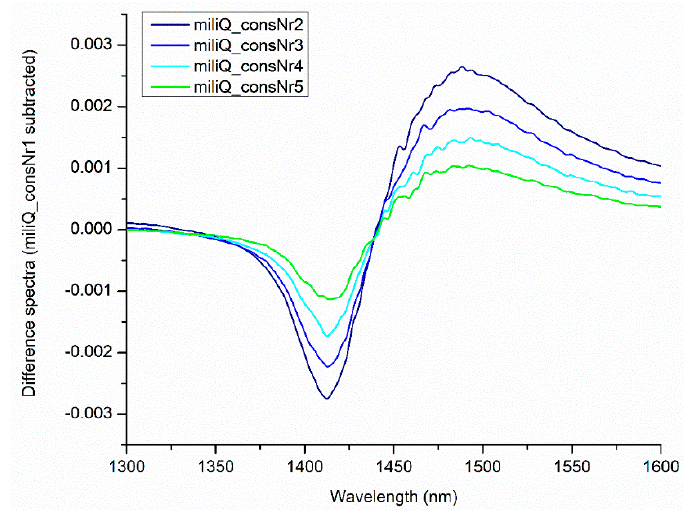
Figure 5. Consecutive illumination of water changes the near infrared spectra. Di ff erence spectra calculated by subtracting the first consecutive spectrum from four subsequently acquired spectra under consecutive illuminations (the same spectra from Figures 3 and 4), show that near infrared light changes the water spectral